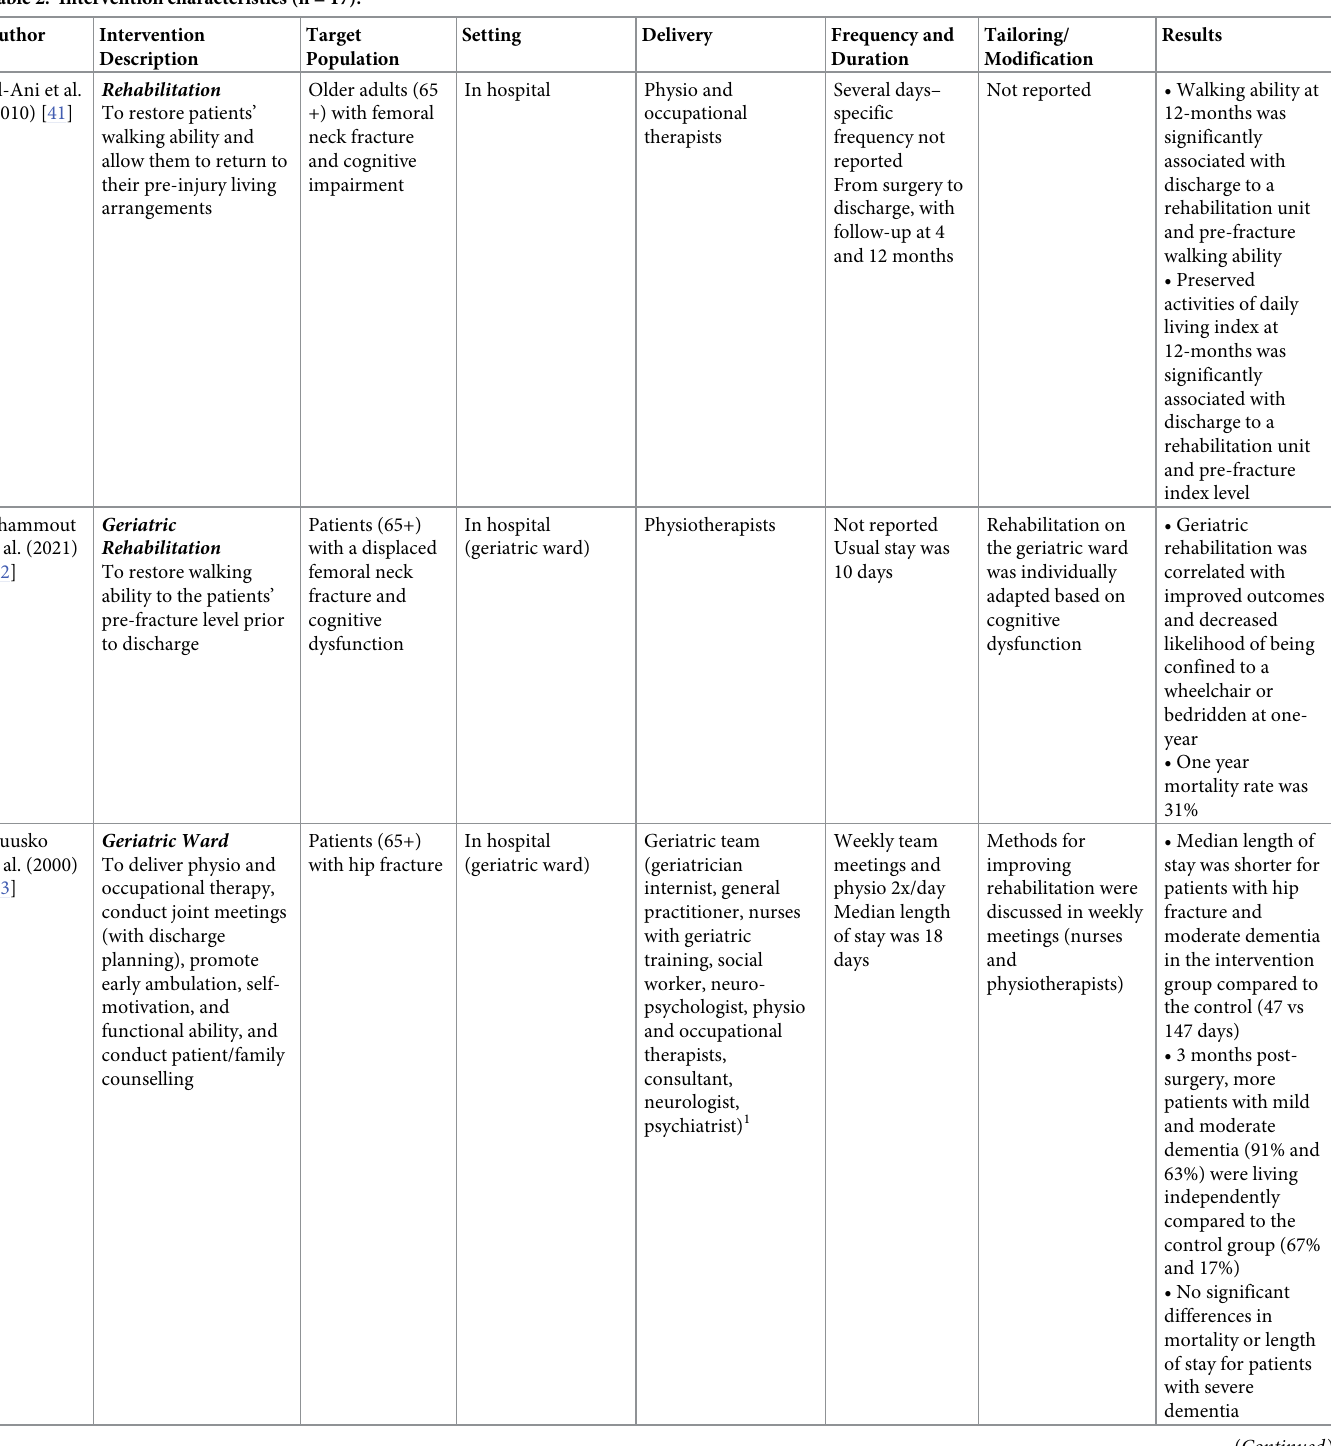
Table 2. Intervention characteristics (n =